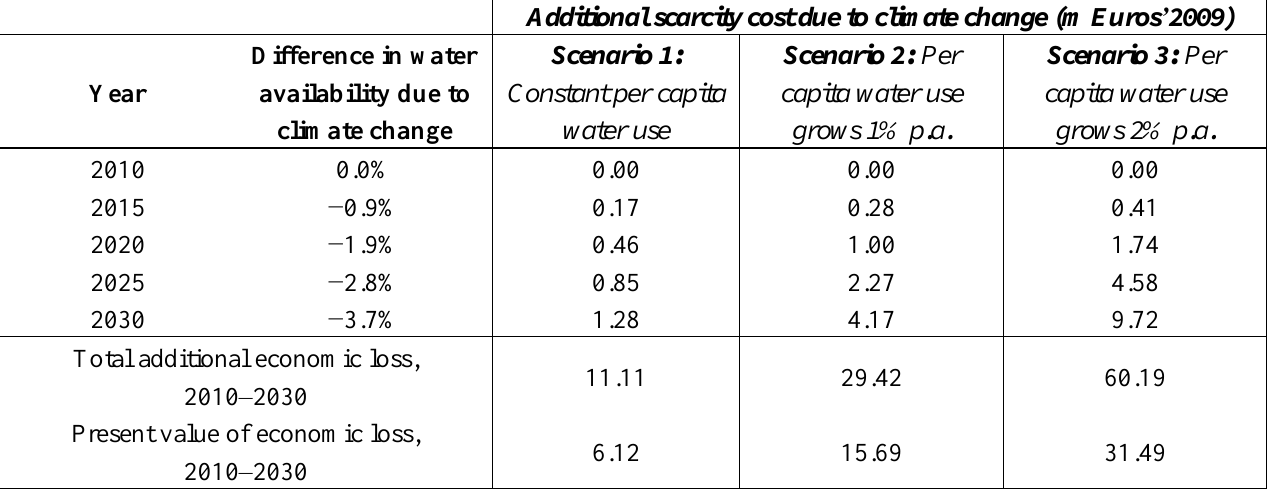
Table 2. Annual costs of residential water shortages in Cyprus under climate change assumptions.